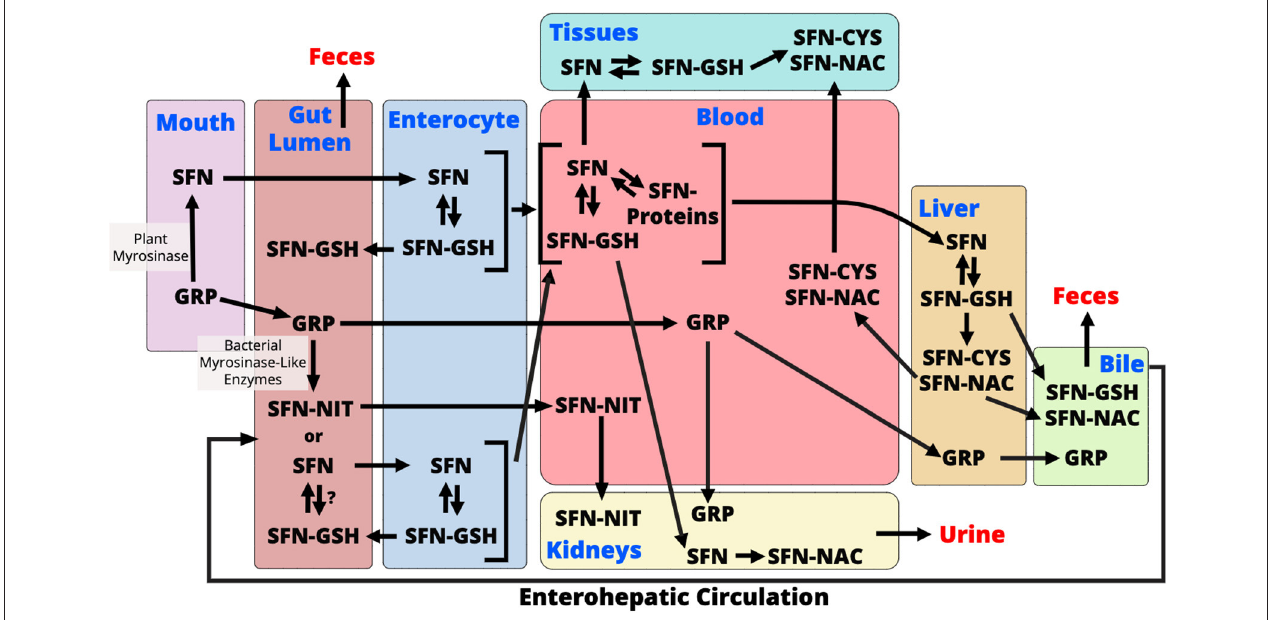
FIGURE 1 | During chewing of raw broccoli sprouts, plant myrosinase converts glucoraphanin (GRP) to sulforaphane (SFN) in the mouth. In the gut lumen, GRP is further converted to either SFN or sulforaphane-nitrile (SFN-NIT) by the gut microbiome. It is unclear if microbes conjugate SFN to glutathione (GSH), however, only free SFN is taken up into enterocytes. Within the enterocyte, SFN-GSH is either excreted back into the gut lumen or enters circulation where it is exists as SFN-GSH or in its free form which conjugates with blood proteins. SFN is transported to either tissues where it exerts its bioactivity or to the liver where it is metabolized via the mercapturic acid pathway. Mercapturic acid metabolites, SFN-cysteine (SFN-Cys) and SFN-N-Acetyl-Cysteine (SFN-NAC), from the liver are either exported to the bile for excretion to the feces, or back into the blood to go to tissues. SFN also goes to the kidney where it is converted to SFN-NAC and excreted into the urine. Un-hydrolyzed GRP is either excreted into the feces or absorbed where it is either transported to the kidneys to be excreted in urine or to the liver where it is excreted into bile. GRP that undergoes enterohepatic circulation and is either hydrolyzed in the gut or excreted to the feces. SFN-NIT is absorbed from the gut lumen where it is transported to kidneys for excretion into urine. SFN-NIT metabolism in humans needs further